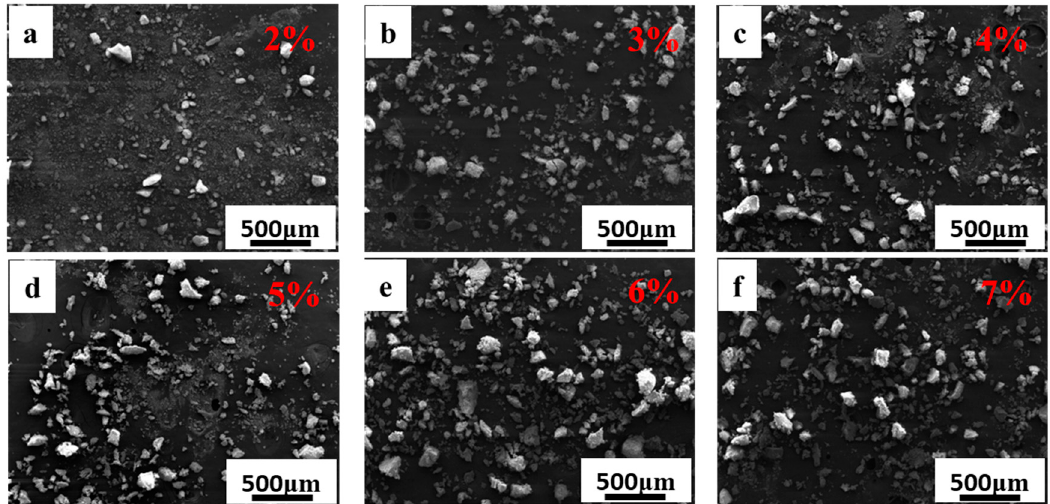
Figure 2. SEM images of SiC/PVB composite powders with the PVB binder contents in the range of 2 to 7 wt. %. ( a – f ) are 2 wt. %, 3 wt. %, 4 wt. %, 5 wt. %, 6 wt. % and 7 wt. %, respectively.